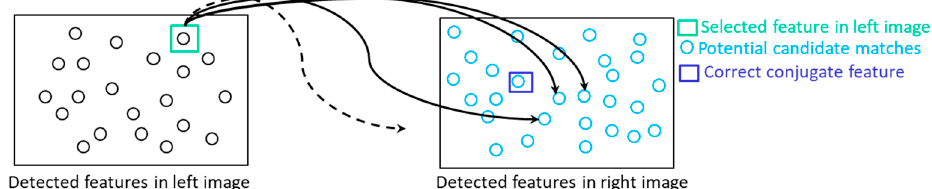
Figure 12. Traditional exhaustive matching strategy: each feature descriptor in the left image is compared with all feature descriptors in the right image.